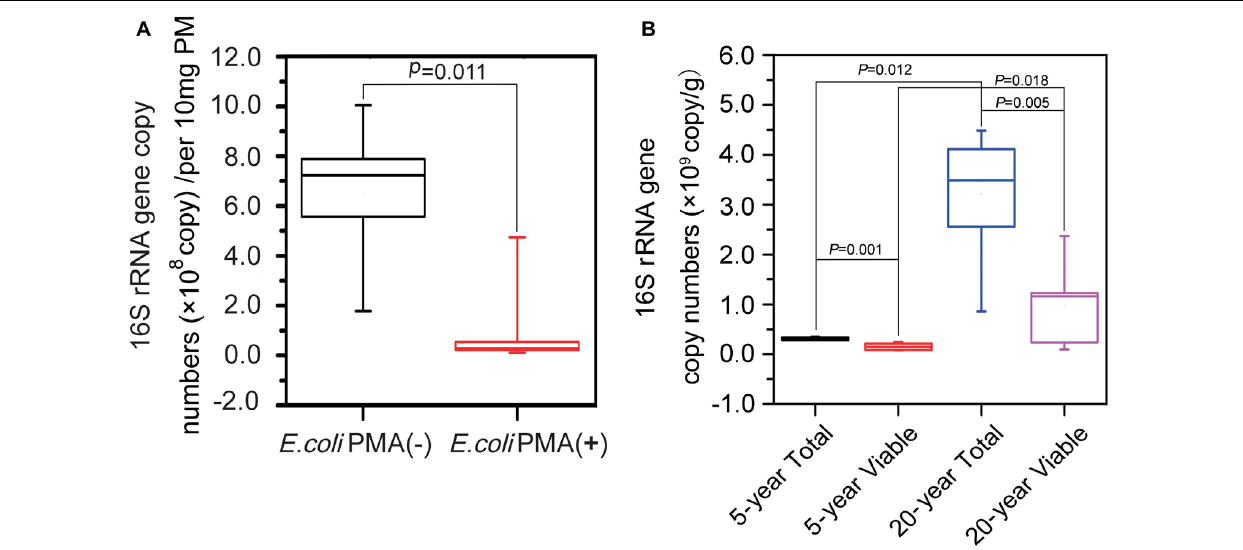
FIGURE 2 | Abundance analysis of total bacteria and viable bacteria of the PMs by qPCR. (A) The positive control composed of dead E. coli and PM sample suspension was untreated [ E. coli PMA (-)] and treated [ E. coli PMA (+)] with PMA for quantifying total bacteria and viable bacteria, respectively. (B) 5-year PM and 20-year PM were untreated with PMA for quantifying total bacteria (5-year Total, 20-year Total) and treated with PMA for quantifying viable bacteria (5-year Viable, 20-year Viable). The Mann–Whitney U -test was used to compare the abundance of 16S rRNA genes by SPSS software.